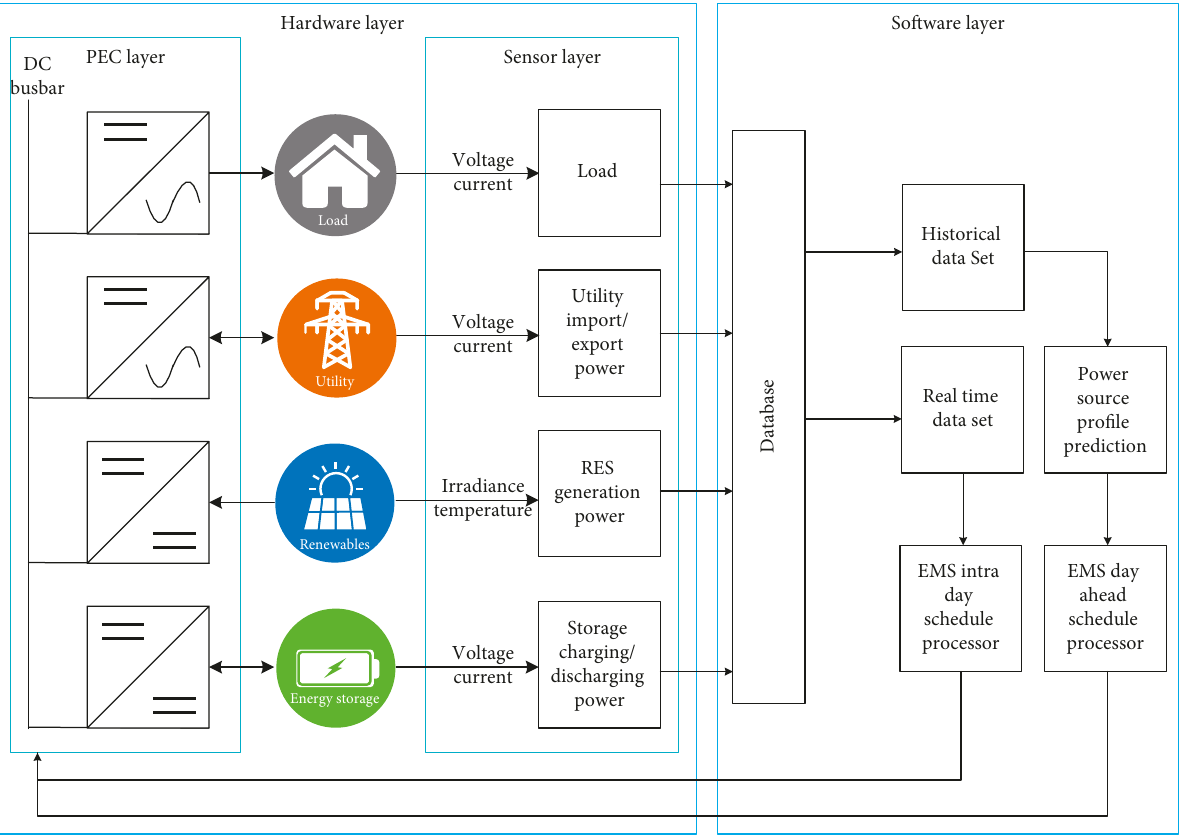
Figure 1: Structure of a typical